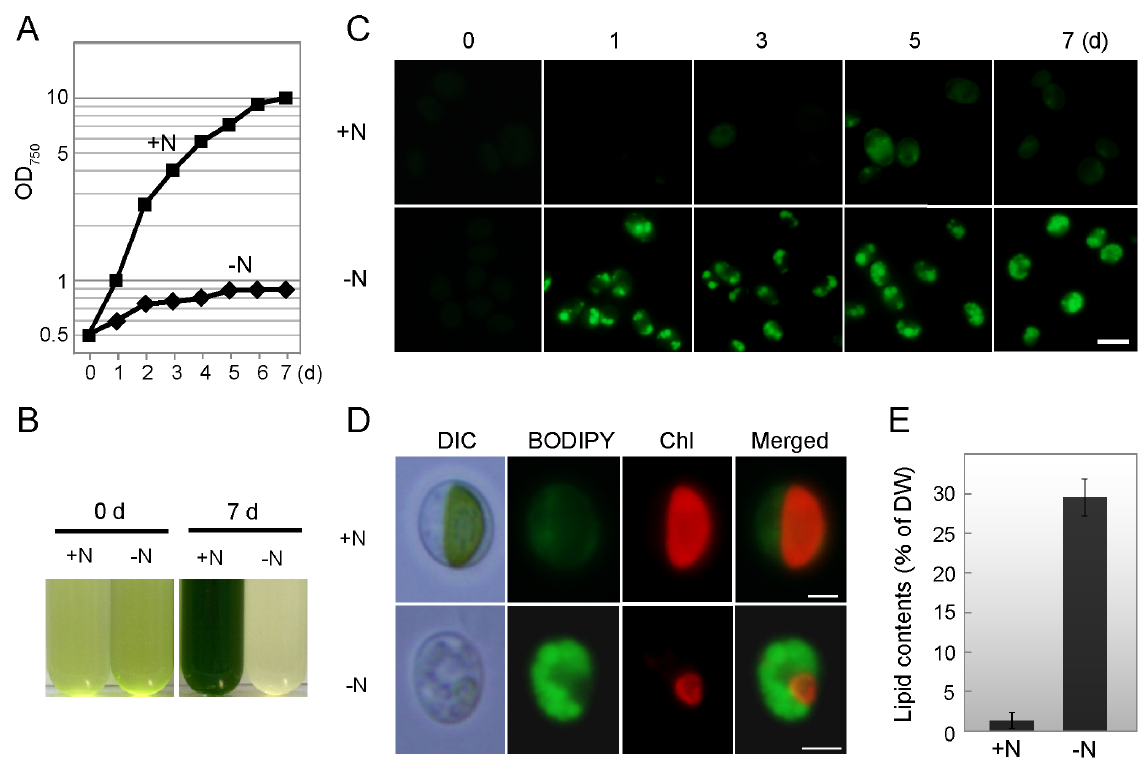
Figure 4. Accumulation of lipid droplets under the nitrogen-depleted condition (pH 3.0, 25 6 C). (A) Growth curves of YKT1 under nitrogen-replete ( + N) or nitrogen-depleted (–N) conditions. (B) Photographs of the cultures under + N or –N conditions at 0 and 7 days after the onset of cultivation. (C) Time course of storage lipid accumulation under + N or –N conditions. Lipid droplets were stained with BODIPY (green fluorescence) and cells were observed under fluorescence microscopy. (D) Micrographs of cells that were cultured under the + N or –N conditions for 7 days. Images were obtained by differential interference contrast microscopy (DIC), BODIPY staining (BODIPY), chlorophyll autofluorescence (Chl), and merged images of BODIPY and Chl (Merged) are shown. (E) Storage lipid content (% of dry weight) in YKT1 cultured under + N or –N conditions for 7 days was determined by the Nile Red method [27]. The bars indicate the standard deviation of three individual experiments. Scale bars: 5 m m (C); 2 m m (D).